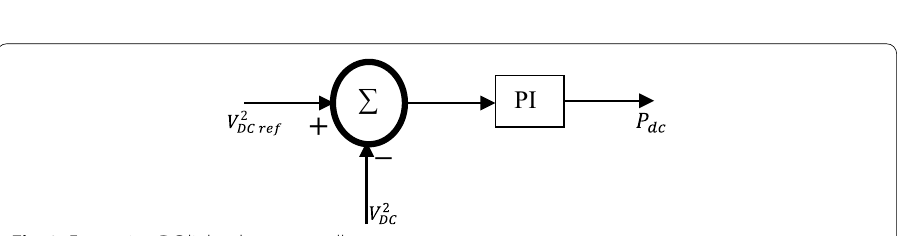
Fig. 9 Fast acting DC link voltage